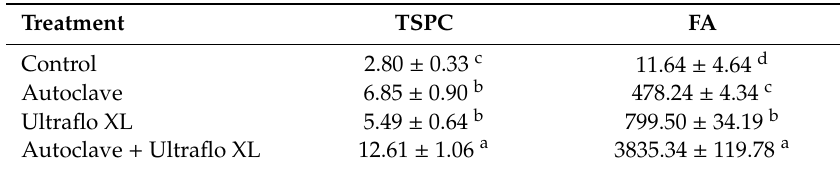
Table 3. TSPC (mg ferulic acid equivalents / g of bran) and free FA ( µ g / g of bran) in WB after single or combined autoclave and Ultraflo XL enzymatic